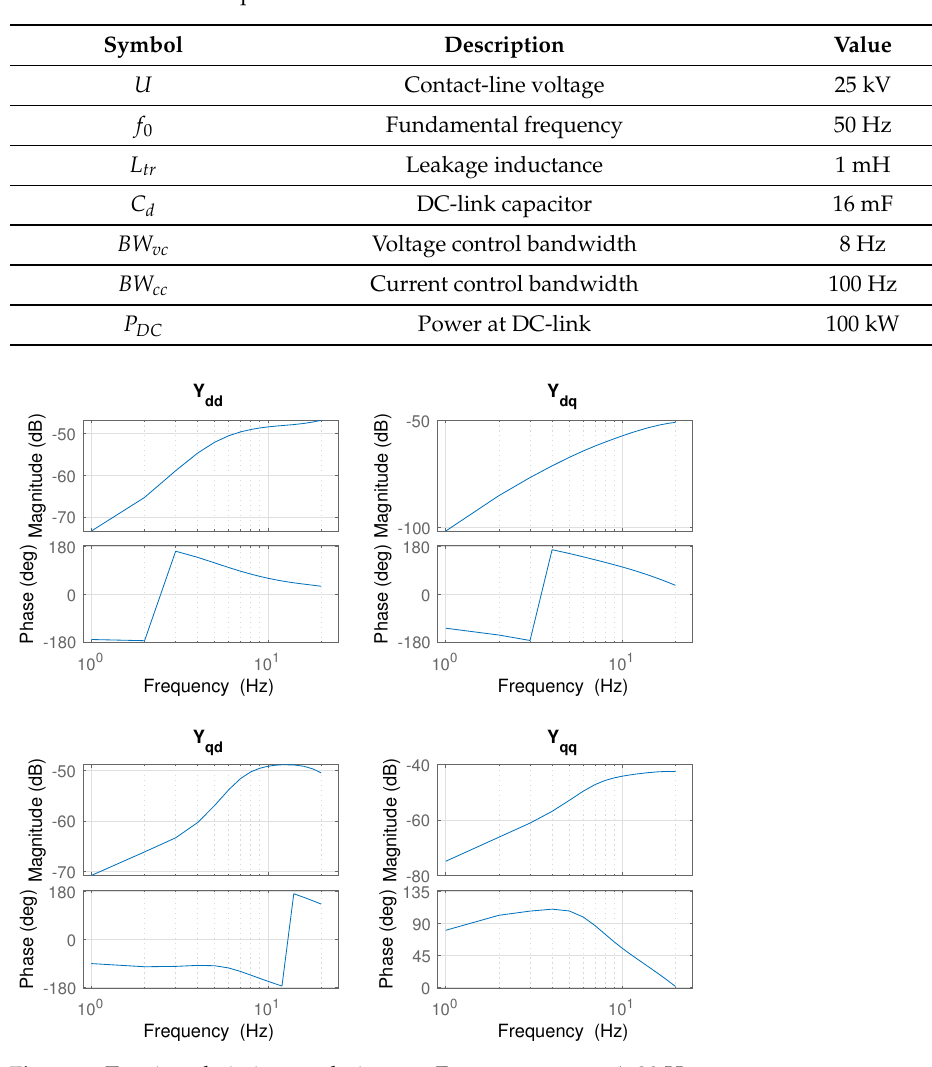
Table 2. Traction chain parameters.